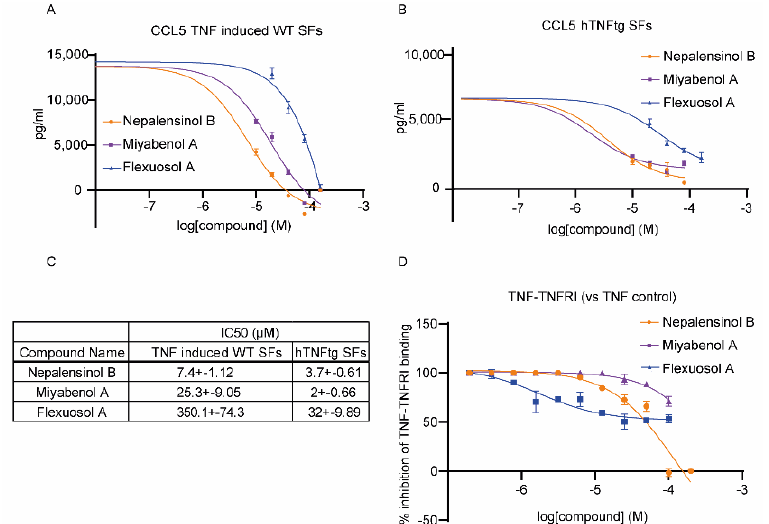
Figure 2. Validation of effective compounds. ( A ) Treatment of WT SFs with several concentrations of the compounds to assess the anti-inflammatory potential of the compounds on exogenous induction of TNF. ( B ) Treatment of hTNFtg SFs, which overexpress hTNF, with several concentrations of the compounds to assess the anti-inflammatory potential of the compounds. ( C ) Table with IC50s values of ( A , B ). ( D ) In vitro TNF-TNFR1 sandwich ELISA to assess the compounds’ potential to inhibit the interaction of TNF with its main receptor TNFR1. All error bars indicate SEM values.